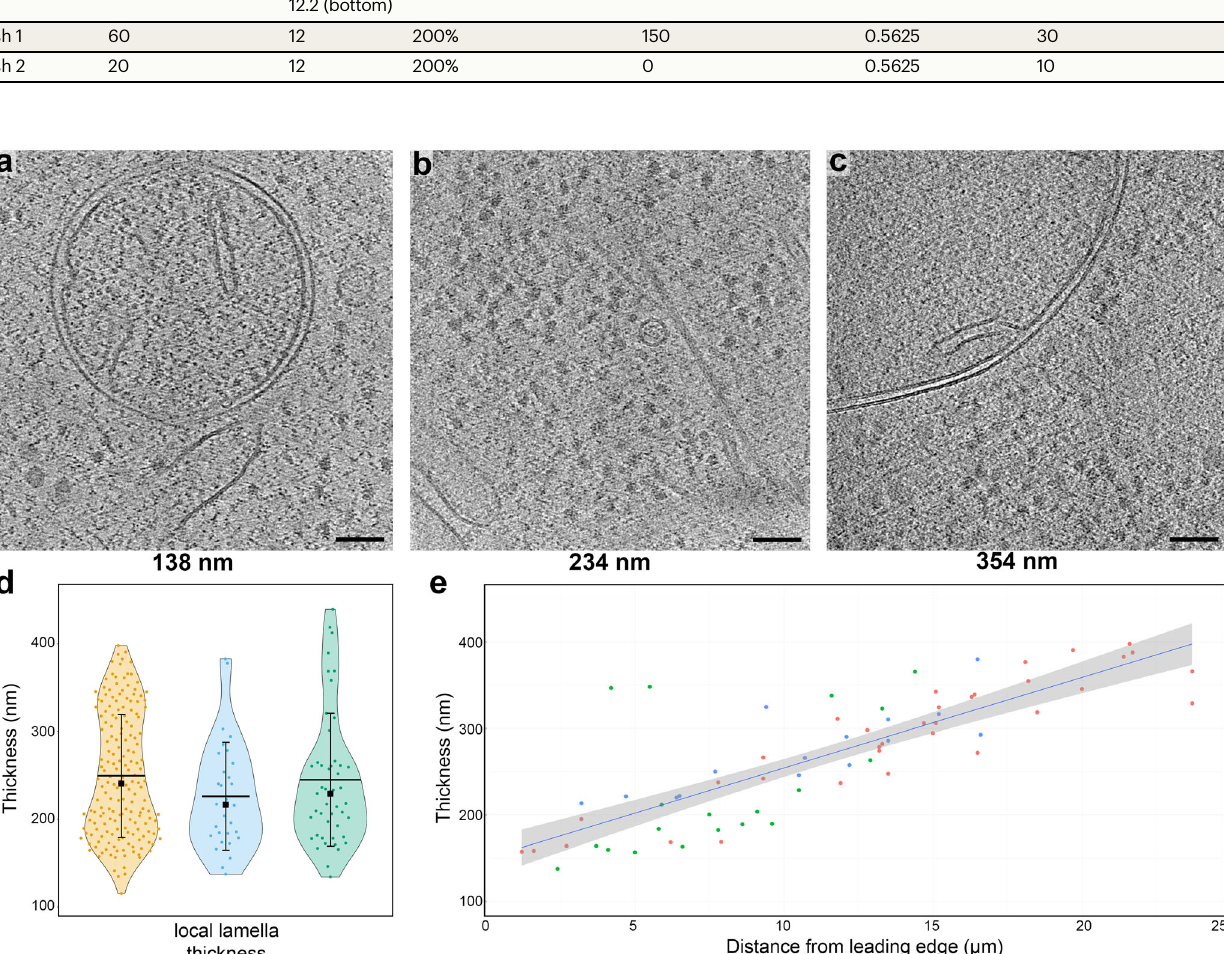
indicatethemeanthickness,errorbarsthestandarddeviationandtheblacksquare the median (from left to right: 241nm, 217nm, 229nm). Source data are provided asaSourceData fi le. e Scatterplotfortomogramthicknessandthedistancetothe front of the lamellae for all tomograms recorded on three different lamellae from the fi rst dataset (datapoints coloured in green, red and blue for each lamella). A lineartrendline(blue)isshown,withthe0.95con fi denceintervalforthetrendline shown in grey. Plots for eight individual tomograms are also shown in Supple- mentary Fig. 6a, and for all the tomograms from the other two datasets in Sup- plementary Fig. 6b, c. Source data are provided as a Source Data fi